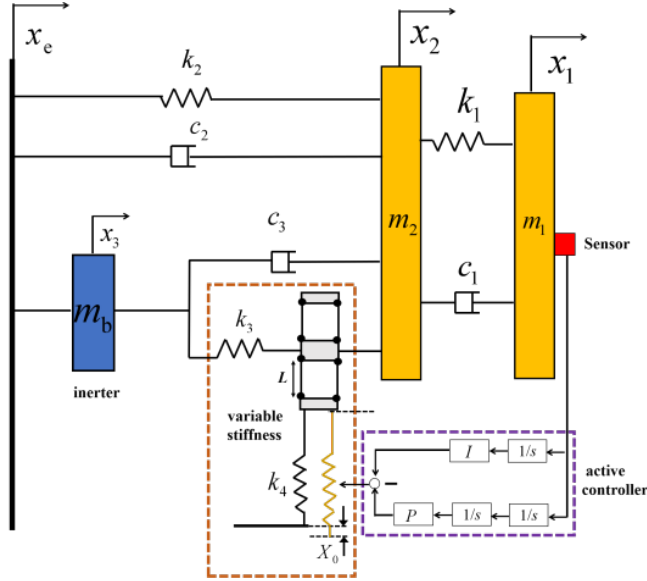
Figure 1. Equivalent model of the primary structure with VS-TMD-I.